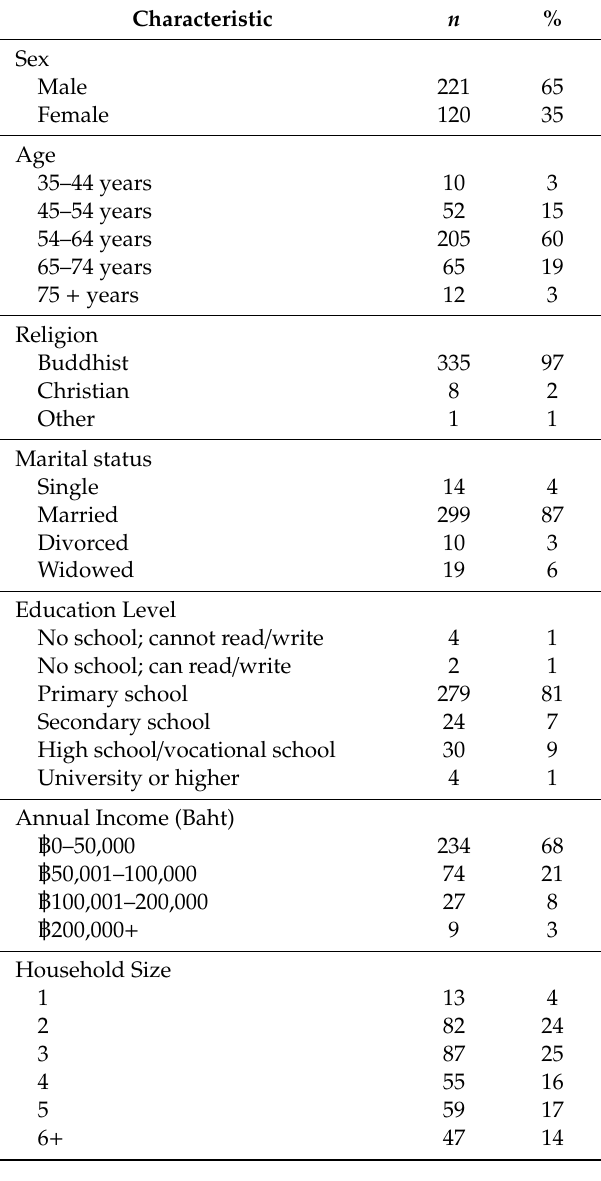
Table 1. Participant Characteristics ( N = 344) 1